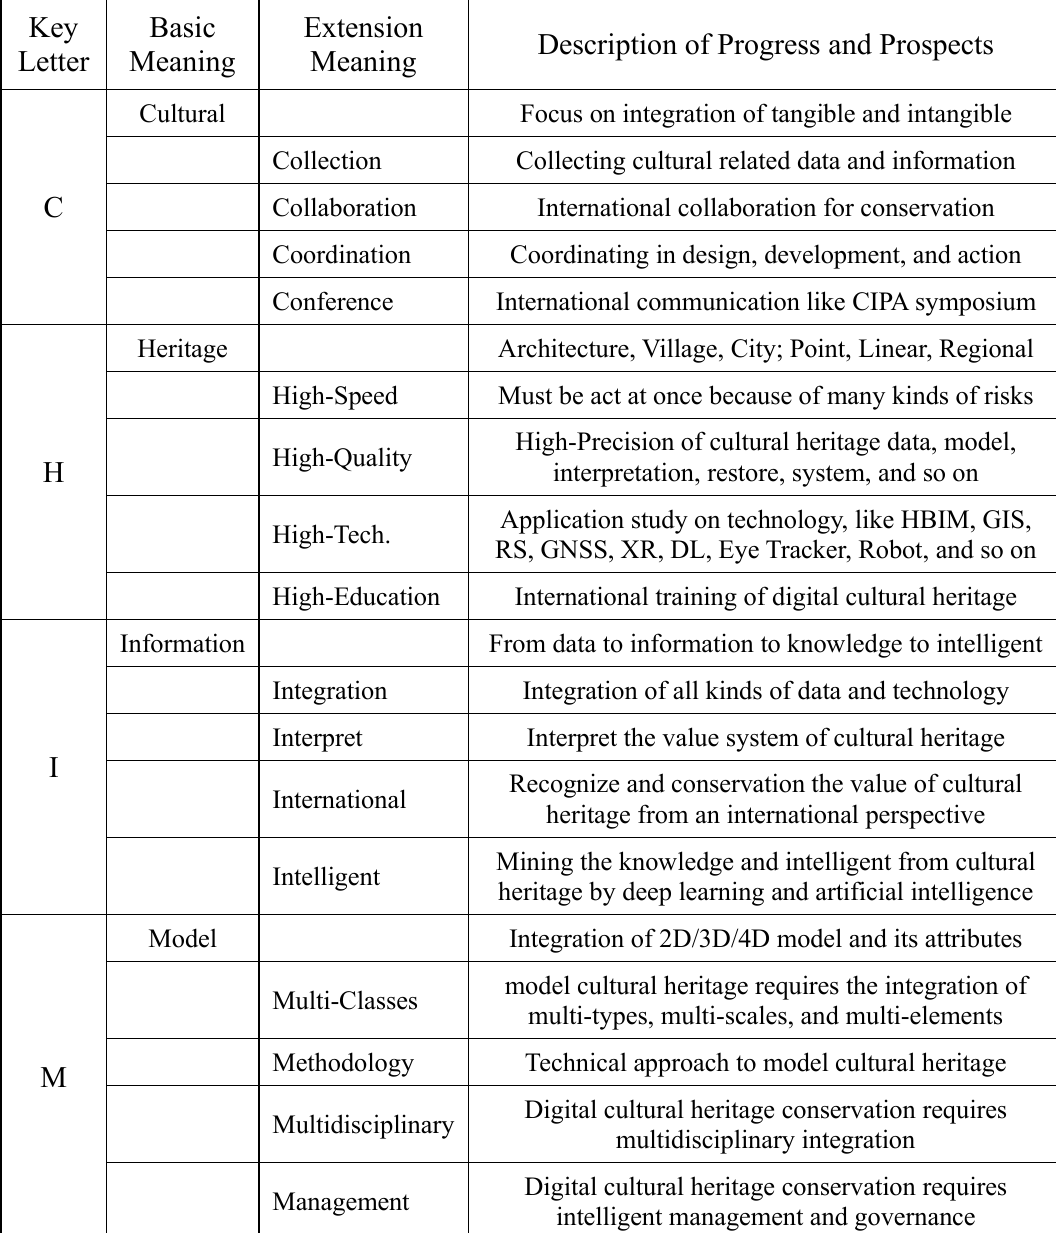
Table 1: CHIM —— Progress and Prospects of Digital Cultural Heritage Key